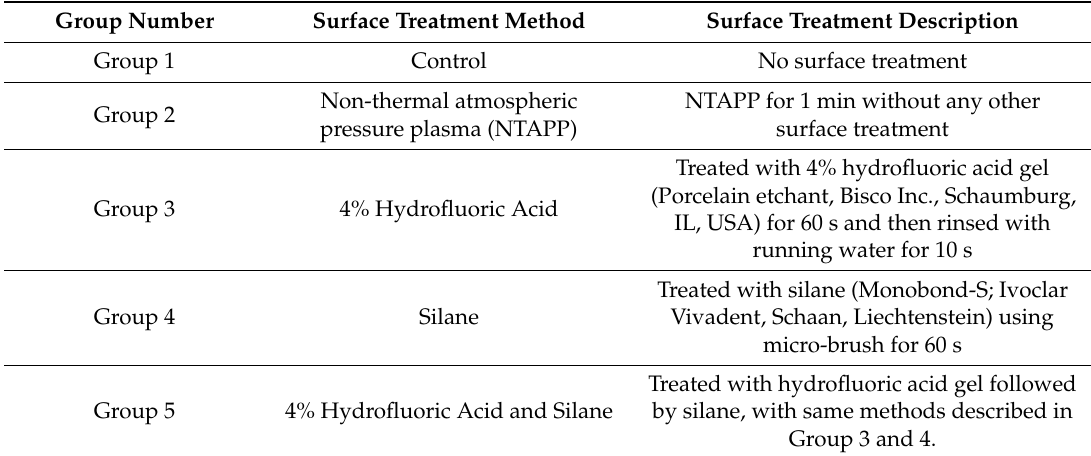
Table 1. Summary of experimental groups for shear bond strength test.